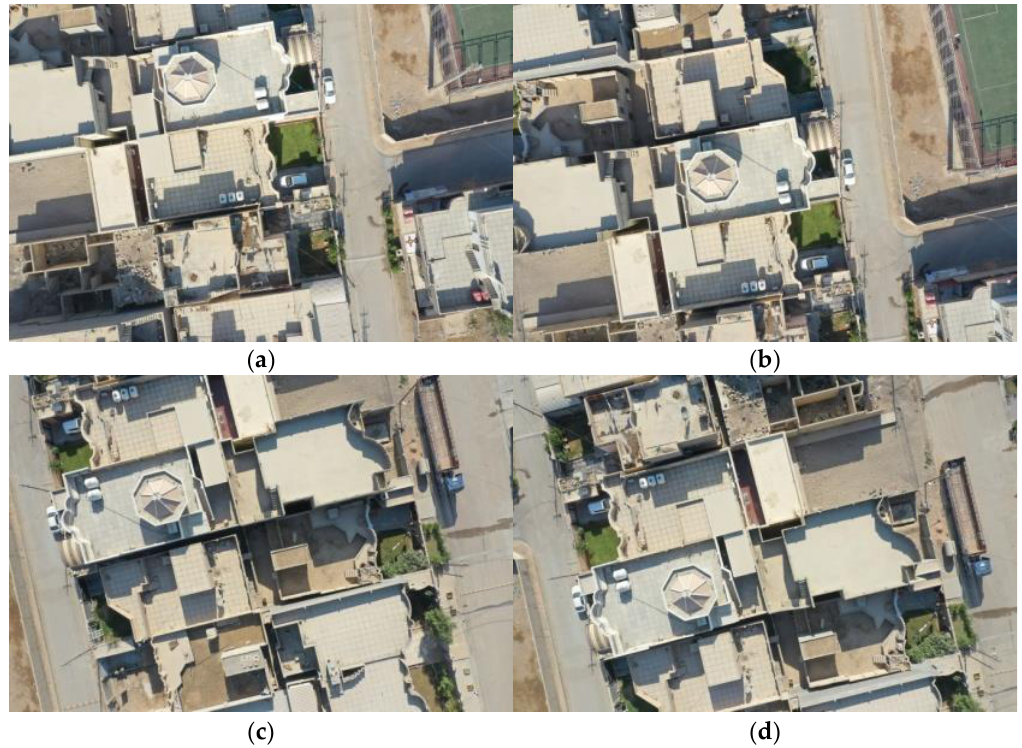
Figure 4. Samples from four adjacent images; the top two images were taken in one flight line and the bottom two images were taken in an adjacent flight line. ( a ) DJI_0891. ( b ) DJI_0892. ( c ) DJI_0908. ( d ) DJI_0909.